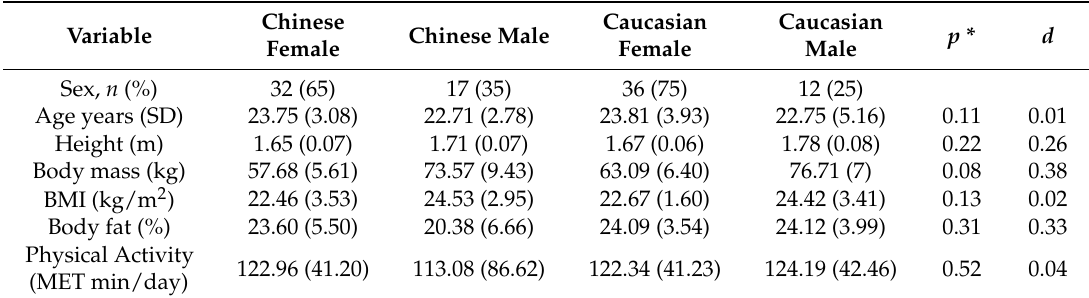
Table 1. Participant characteristics.